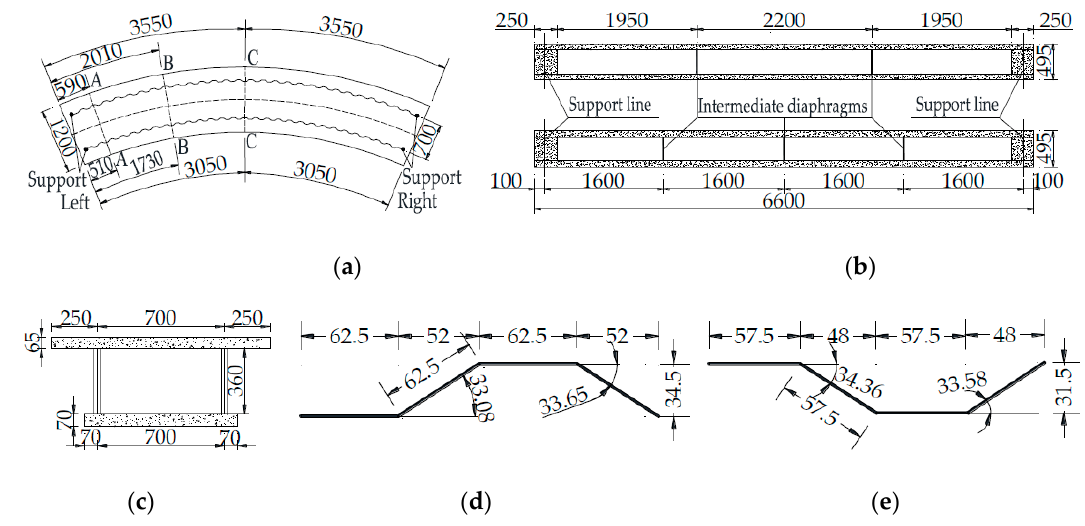
Figure 7. Geometry and dimensions of test girders with CSWs (unit: mm): ( a ) Plan view; ( b ) Elevation view; ( c ) Cross-section; ( d ) Outer CSW; ( e ) Inner CSW. Right: the right-hand side of test girders. Left: the left-hand side of test girders. Table 11. Results of the material tests for the steel used for the CSWs.